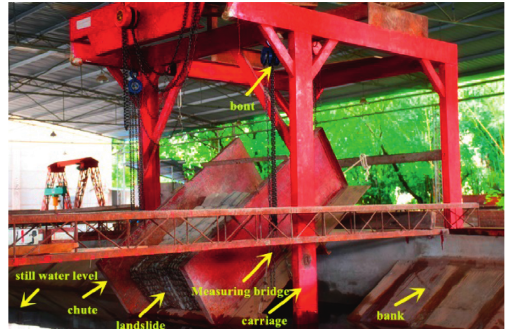
Figure 3: Chute and carriage.